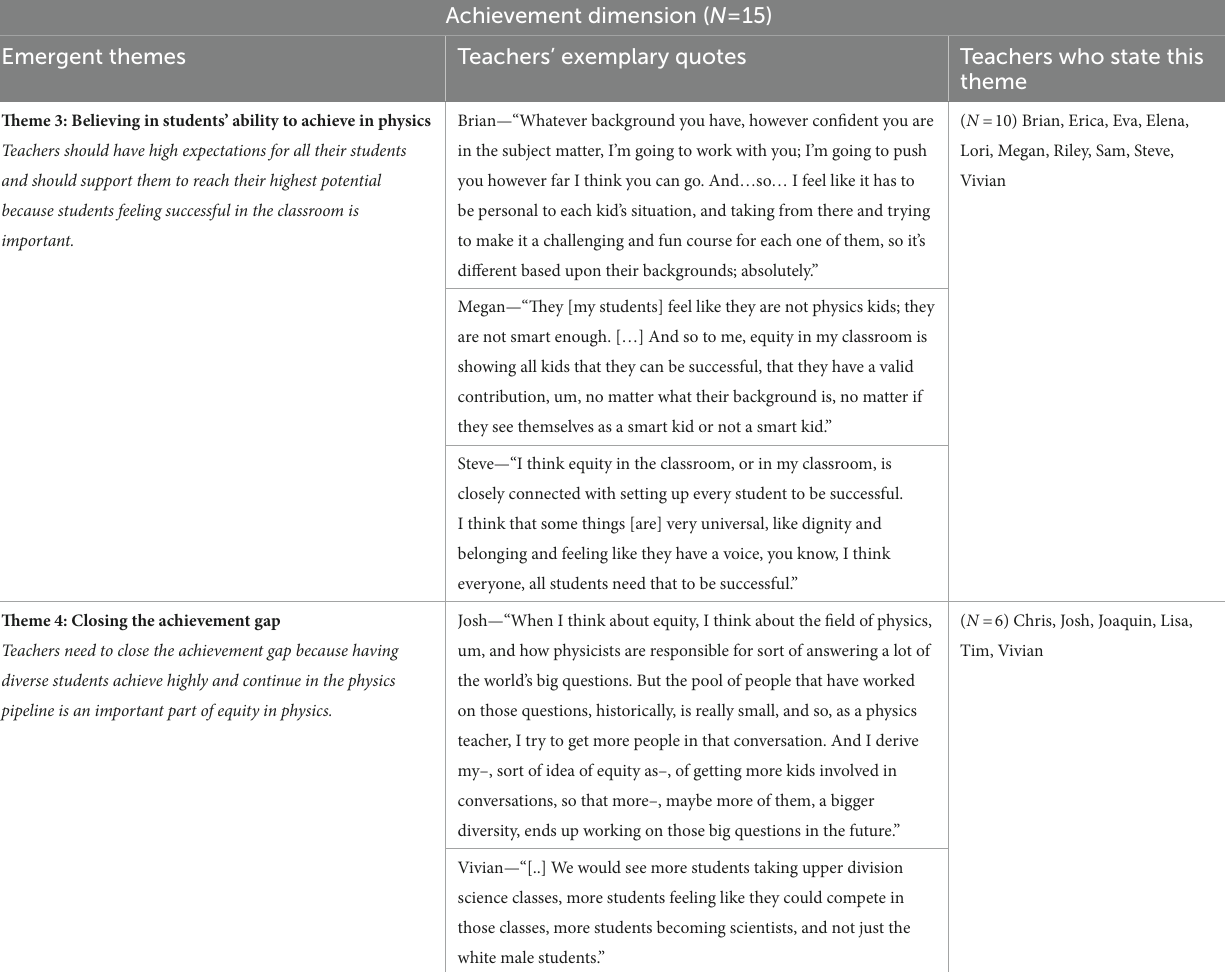
TABLE 3 Emergent themes of teachers’ conceptions of equity in achievement